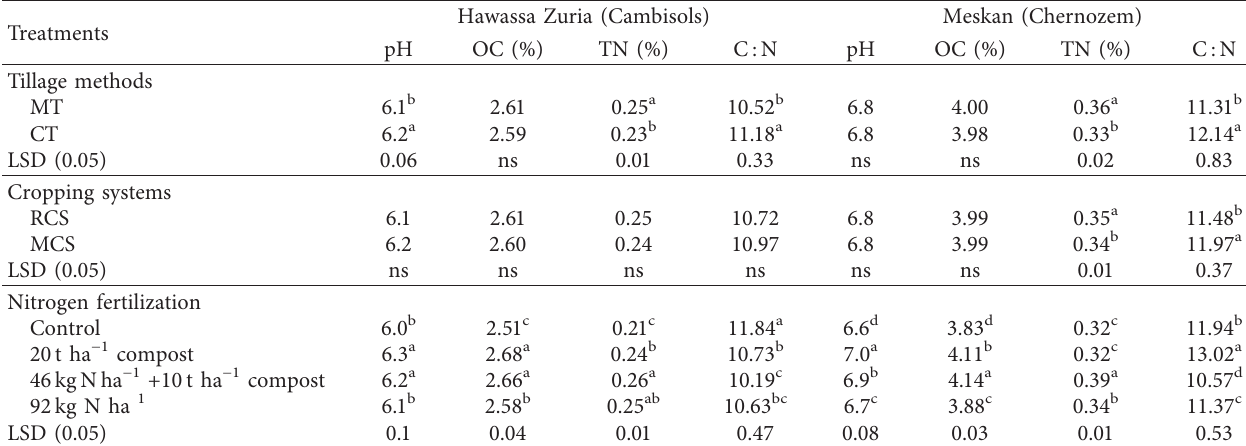
Table 6: Main effects of tillage, cropping systems, and nitrogen fertilization on soil reaction, organic carbon, total nitrogen, and C :N ratio of the surface layer of soils